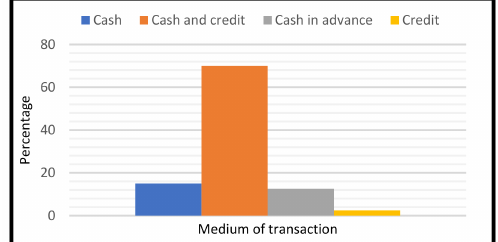
Figure 23. The preferred medium of transaction.